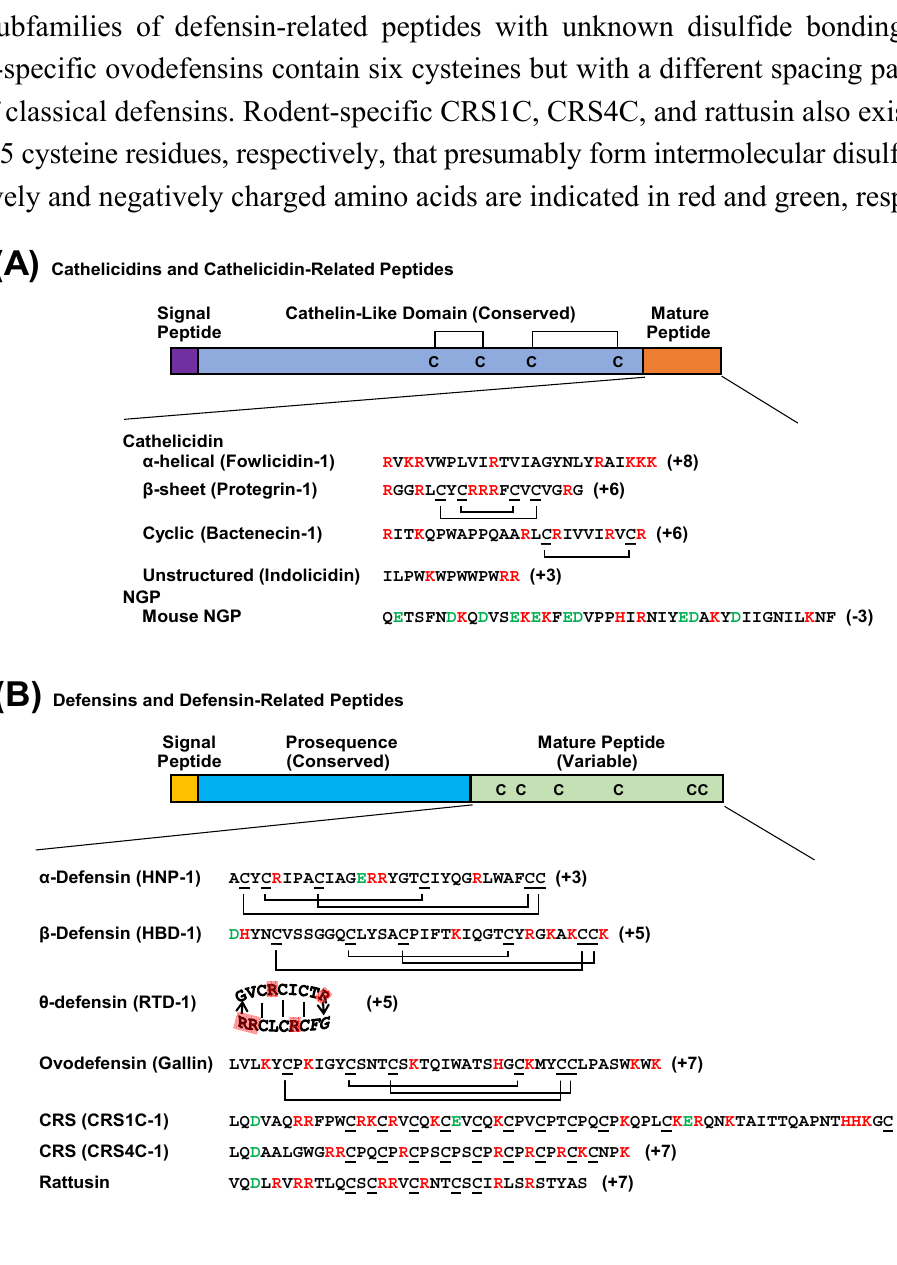
Figure 1. Schematic drawing of vertebrate cathelicidin and defensin precursor peptides. ( A ) Cathelicidins and cathelicidin-related peptides known as NGPs are highly conserved in the cathelin-like domain that contains two disulfide bridges. Unlike cathelicidins whose C-terminal segments are highly variable across species and proteolytically cleaved from the cathelicidin-like domain to become biologically active, NGPs are conserved throughout the entire sequence and functionally active without being processed. ( B ) The defensin